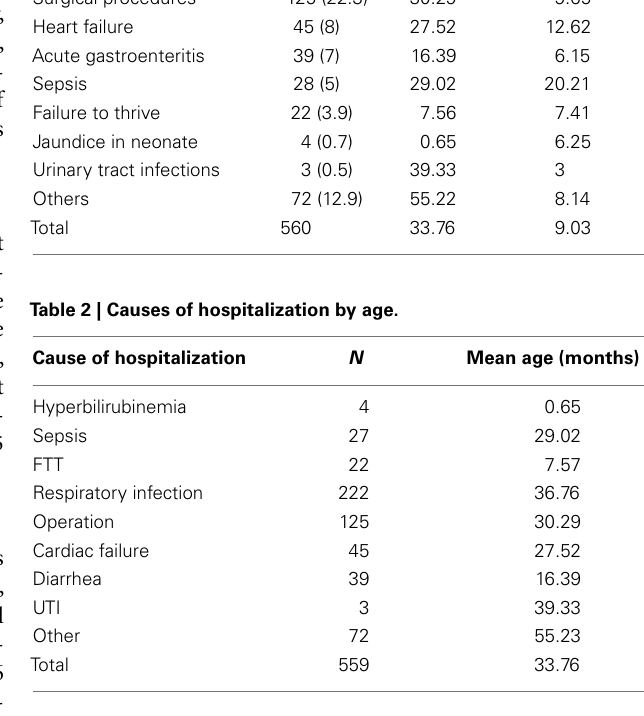
Table 3 | Causes of recurrent